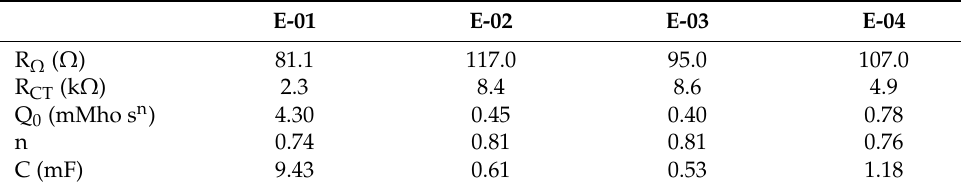
Table 2. Fitting results of the EIS spectra in Figure